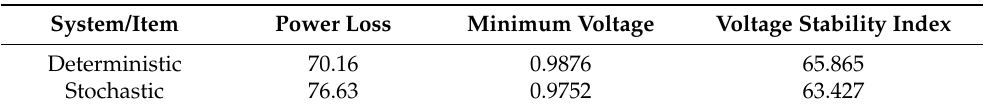
Table 5. Comparison of the results of sitting and sizing of PVs in deterministic and stochastic conditions for a 33-bus distribution